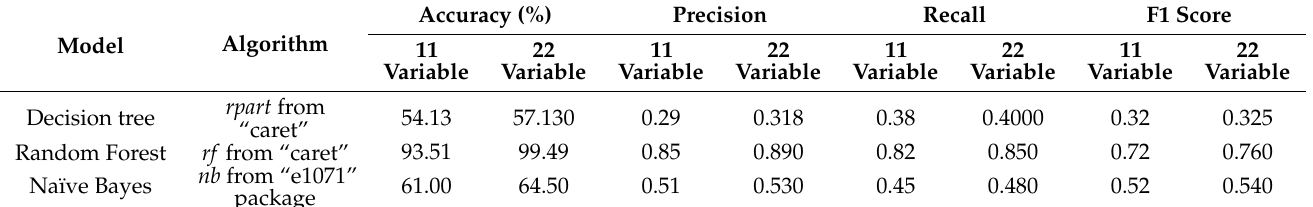
Table 6. Model assessment for decision tree, random forest and Naïve Bayes.